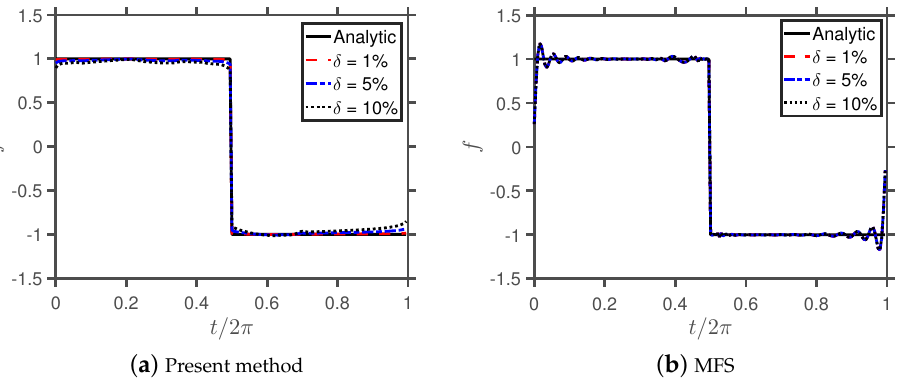
Figure 8. The numerical solutions with various amounts of noise added in the boundary data with jump discontinuities of Example 5, on ∂ D .